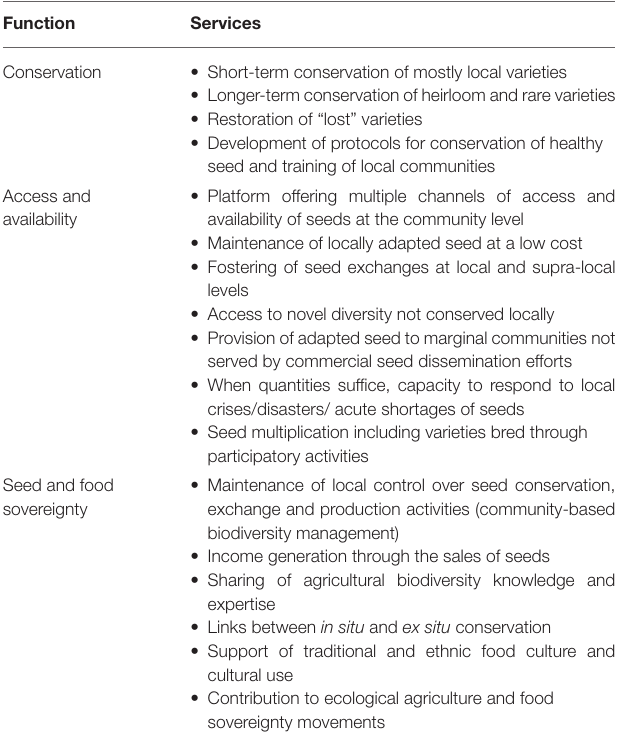
TABLE 1 | Multiple functions and services of community seed